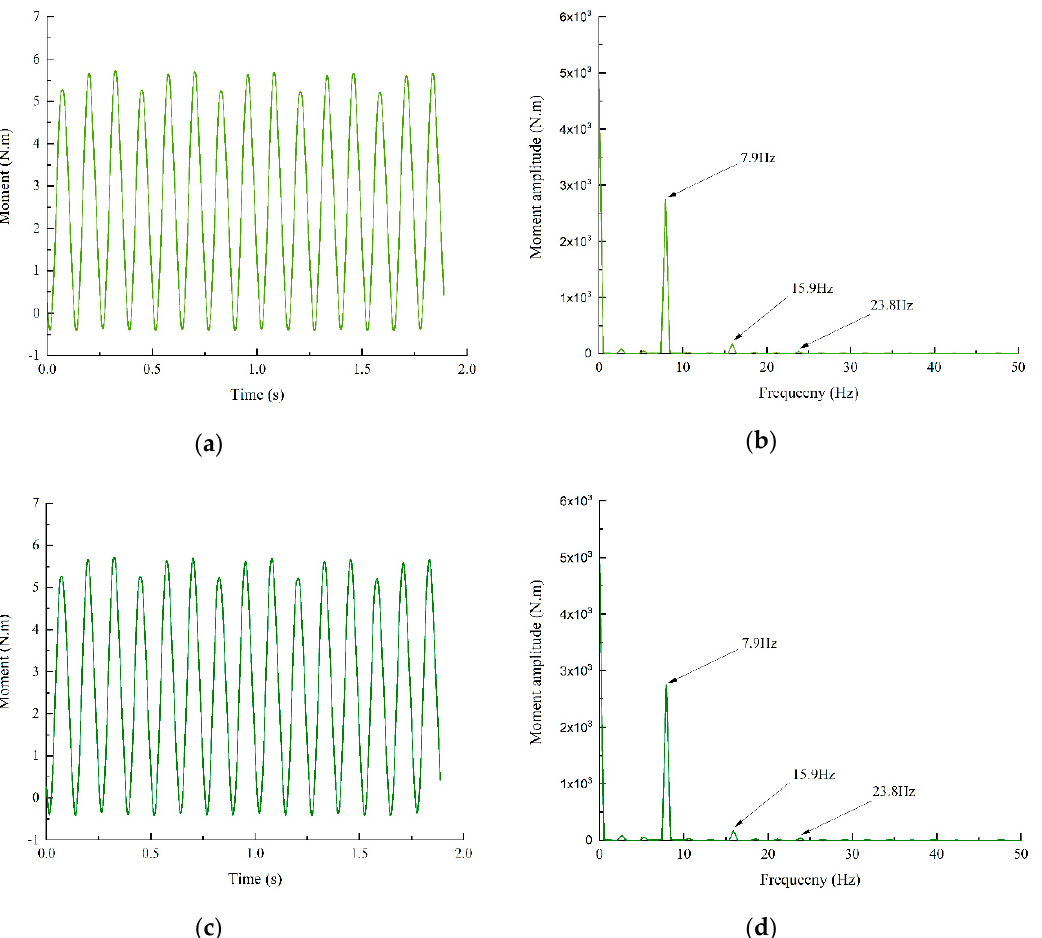
Figure 20. Aerodynamic loads acting on blades of the ( a ) H ‐ type and ( c ) hybrid VAWTs in the Y ‐ direction and their dominant excitation frequencies for the ( b ) H ‐ type and ( d ) hybrid VAWTs.